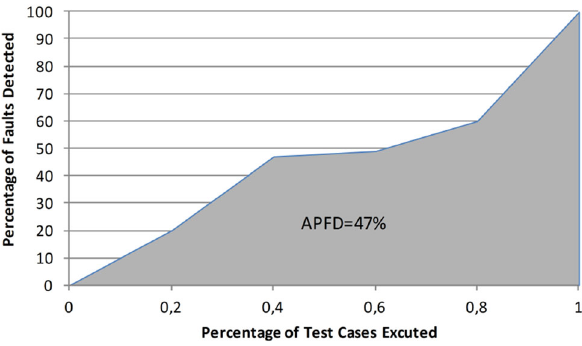
Fig. 4 APFD of particle swarm optimization for an arbitrary test